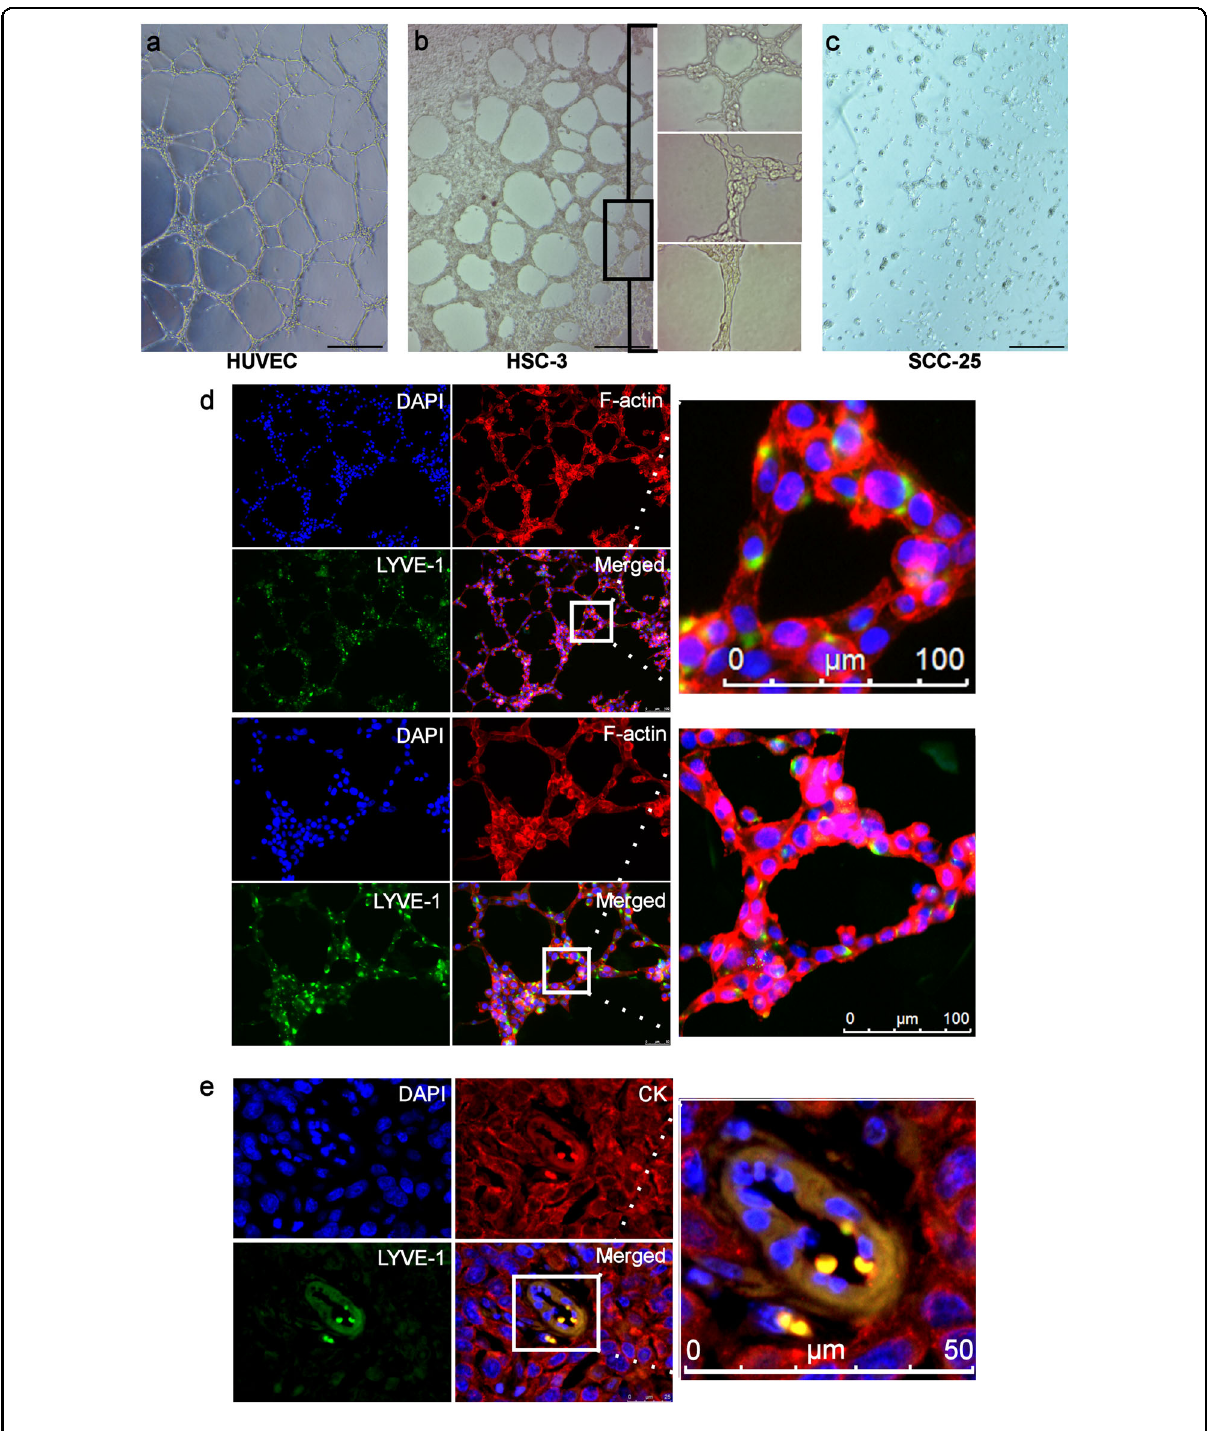
Fig. 3 (See legend on next